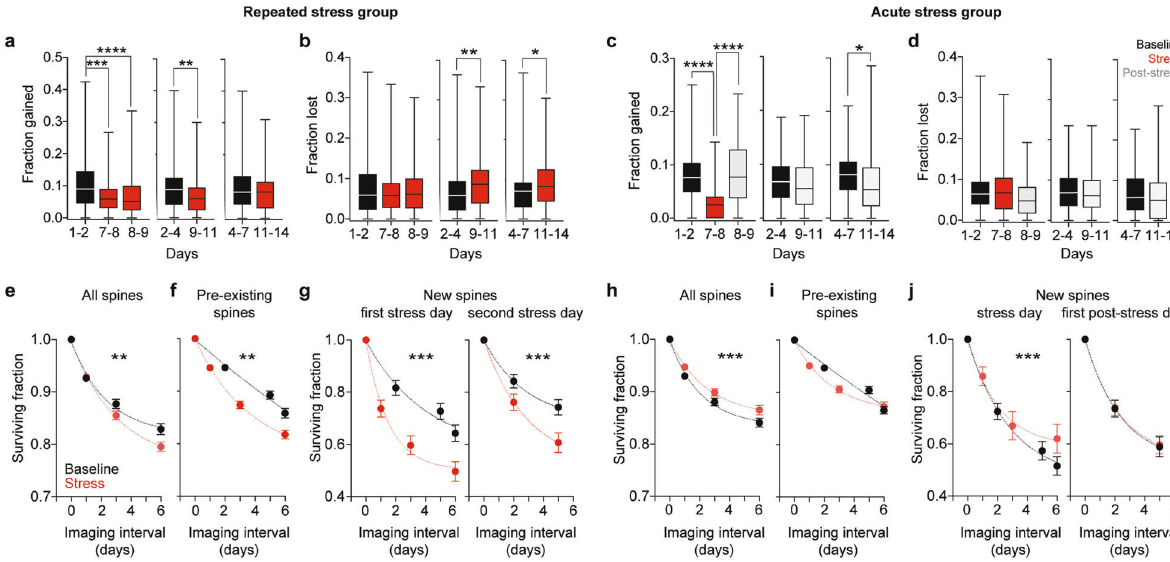
Fig. 4 Repeated and acute stress exposures have different effects on gain, loss and survival of dendritic spines in dCA1 PNs. a Repeated stress exposure decreased the fraction of spines gained in the 1 – 4-day interval after stress onset ( p 7 – 8 = 0.0001, p 8 – 9 < 0.0001, p 9 – 11 = 0.0022, p 11 – 14 = 0.7466, n = 124). b Repeated stress exposure increased the fraction of spines lost in the 4-to-7-day interval after stress onset ( p 7 – 8 = 0.7144, p 8 – 9 > 0.9999, p 9 – 11 = 0.0024, p 11 – 14 = 0.0166, n = 124). c Acute stress decreased the fraction of spines gained immediately after stress exposure ( p 7 – 8 < 0.0001, p 8 – 9 > 0.9999, p 9 – 11 = 0.3483, p 11 – 14 = 0.0182, n = 88). d Acute stress had no effect on spine loss ( f , p 7 – 8 > 0.9999, p 8 – 9 = 0.3263, p 9 – 11 = 0.8860, p 11 – 14 = 0.2665, n = 88). Wilcoxon matched pairs signed ranks tests to 1 – 2, 2 – 4 and 4 – 7 respectively, p -values adjusted after Dunn ’ s correction for multiple comparisons Box plots: medians and quartiles of the distributions of fractional spine gain a , c or loss b , d per dendrite. e – g Repeated stress exposure decreased the survival of all e , pre-existing f and new g spines detected on the fi rst (left) and second (right) days of stress. p All = 0.003, p Pre-existing = 0.001, p NewFirstday < 0.001, p NewSecondday < 0.001, n All = 372, n Pre-existing = 372, n NewFirstday = 312, n NewSecondday = 130. h – j A single exposure to stress increased the survival of all spines ( h ), but it did not affect pre-existing spines ( i ). Increase in spine survival was due to increased survival rate of new spines detected on the day of stress ( j , left) but not on the following day ( j , right). p All < 0.001, p Pre-existing = 0.251, p NewFirstday < 0.001, p NewSecondday = 0.861, n All = 264, n Pre-existing = 264, n NewFirstday = 177,